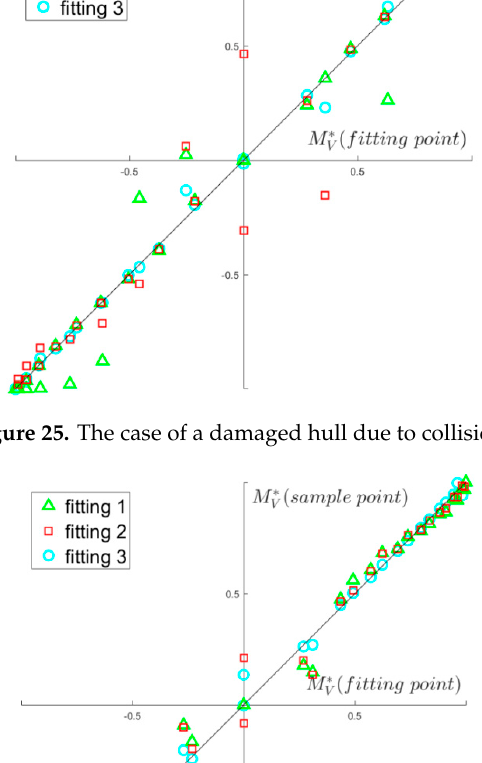
Table 8. Goodness of fit for the case of the intact hull.